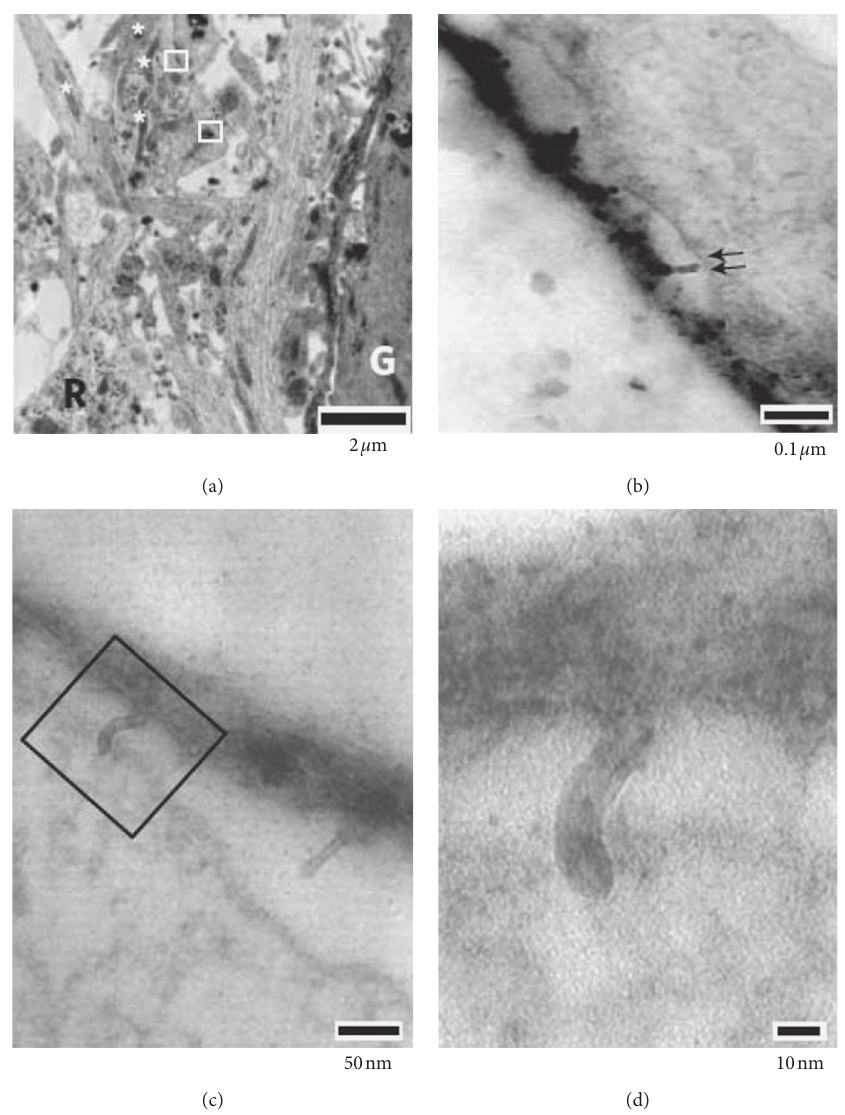
Figure 5: Interaction between MWCNTs and neurons. (a) Transmission electron micrographs (TEM) sections of neurons grown on MWCNTs showing functional synaptic contacts (rectangular box). (b) Arrows indicate MWCNT-membrane contacts on this TEM section from (a). (c, d) High-magnification micrographs from a section consecutive to those of (b) illustrating how MWCNTs ‘pinch’ neuronal membranes